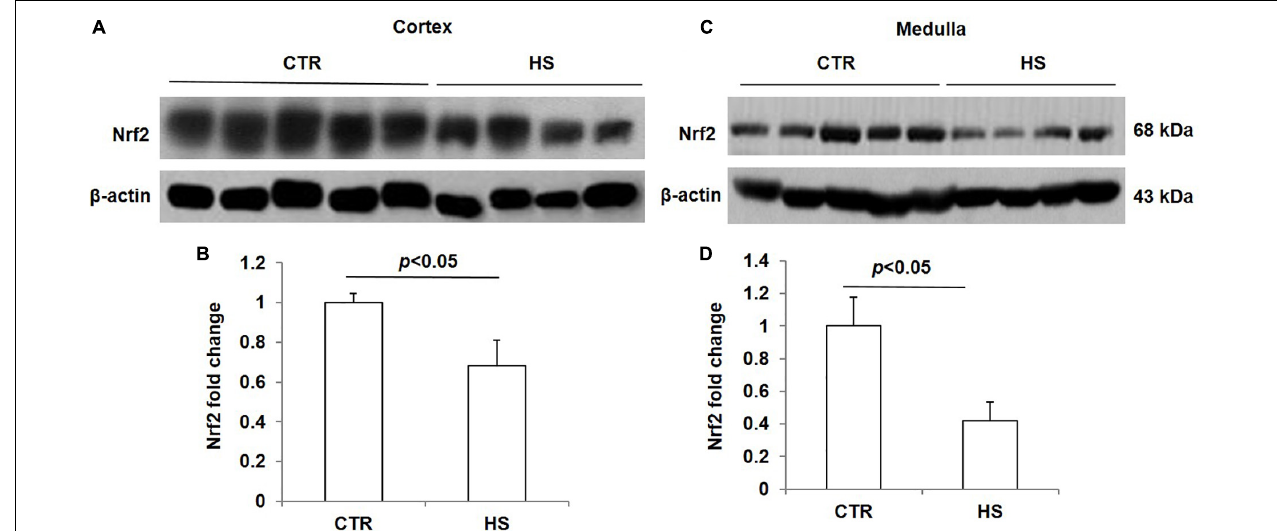
FIGURE 1 | Nrf2 protein expression in kidneys after acute high salt loading. (A) Western blotting analysis of Nrf2 and β -actin in renal cortex. (B) Densitometric analysis of Nrf2 normalized by β -actin in cortex tissue. (C) Western blotting analysis of Nrf2 and β -actin in renal medulla. (D) Densitometric analysis of Nrf2 normalized by β -actin in medulla tissue. The presented data are means ± SE. Control (CTR): n = 5; high salt loading (HS): n =